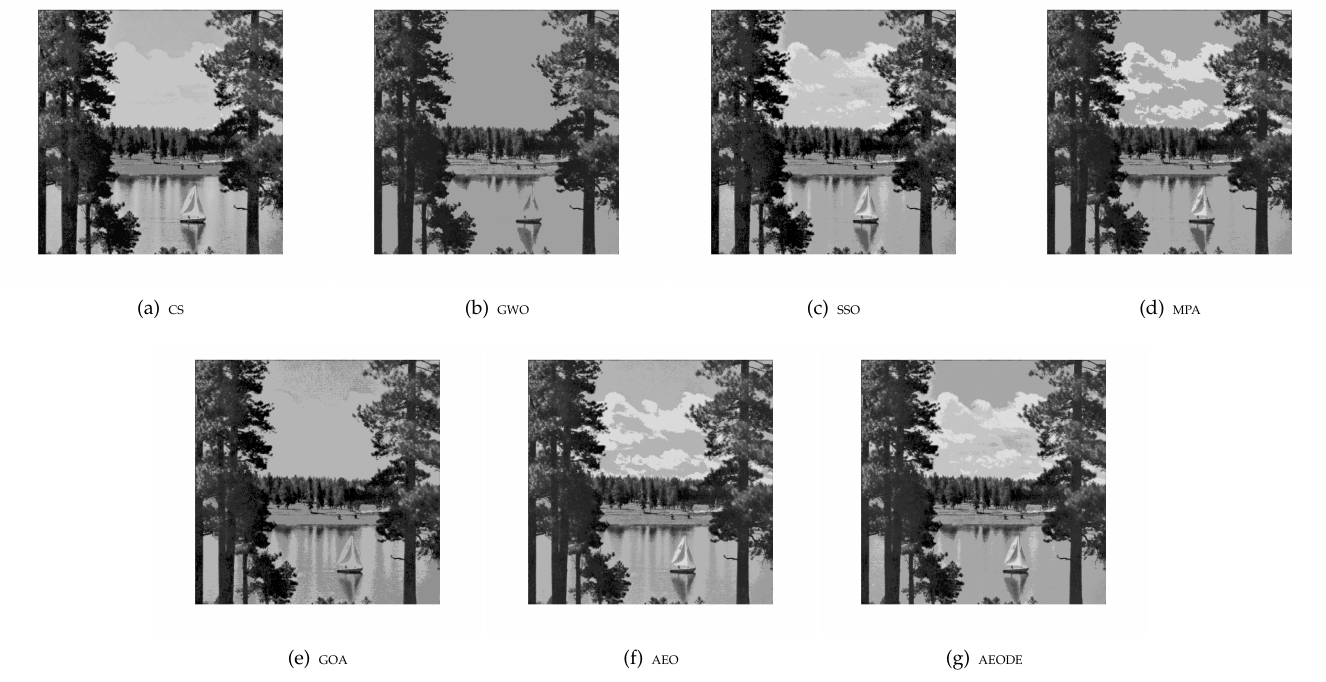
Figure 10. Segmented image I7 at threshold level